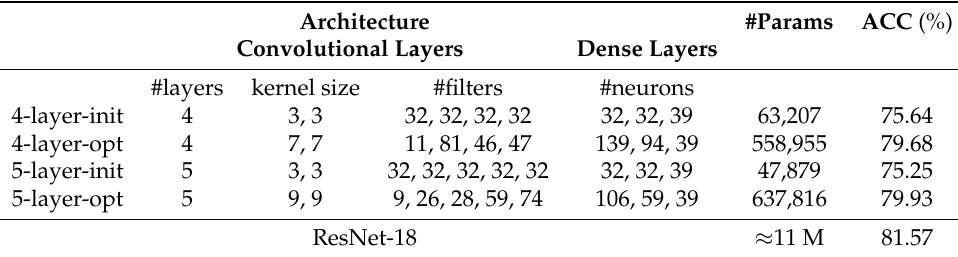
Table 1. Architectures, complexity (in number of parameters), and phoneme classification accuracy (ACC) for the initial and optimized CNN models, and for the ResNet-18